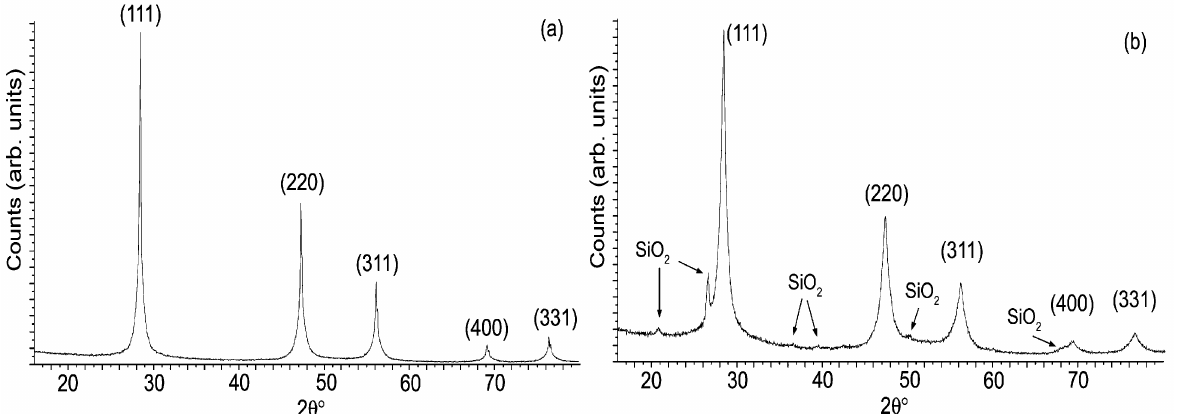
Figure 2. XRPD patterns for porous samples: ( a ) pSi-0.1 sample milled 0.1 h, and ( b ) pSi-2 sample milled 2 h: the SiO phase is 2